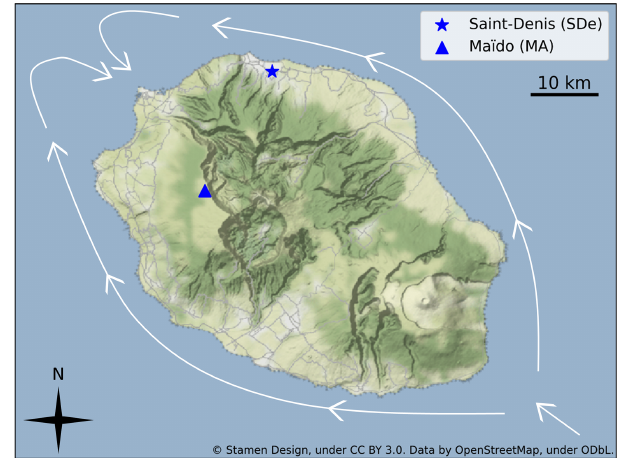
Figure 1. Map of Réunion Island, indicating the location of the two measurement sites: Saint-Denis (star) and Maïdo (triangle). The white arrows roughly illustrate the local wind patterns, which are generated by the trade winds and the orography of the